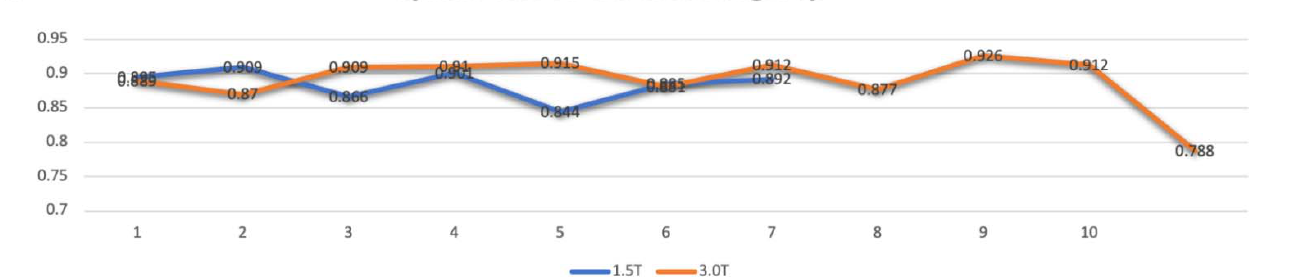
Figure 5. System performances on the external validation group. ( A ) 1.5T MR scanner platform; ( B ) 3.0T MR scanner platform; ( C ) Dice score of each patient in Table 1: Characteristics of patients involved in the experimental dataset.